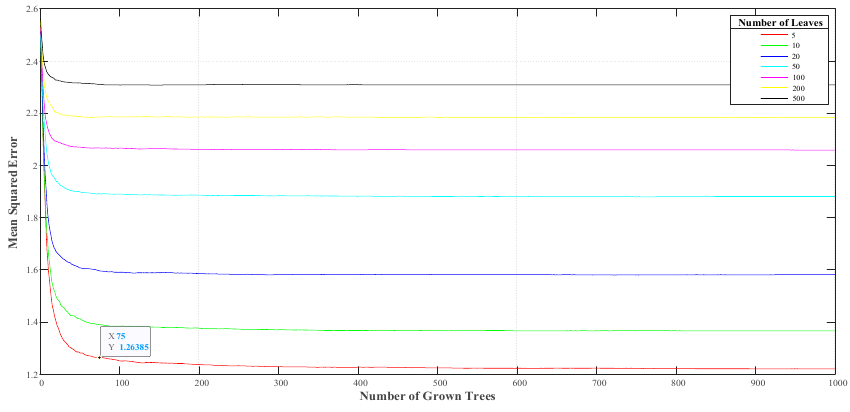
Figure 13. Parameter selection of improved random forest (cleaning rate 46.44%).